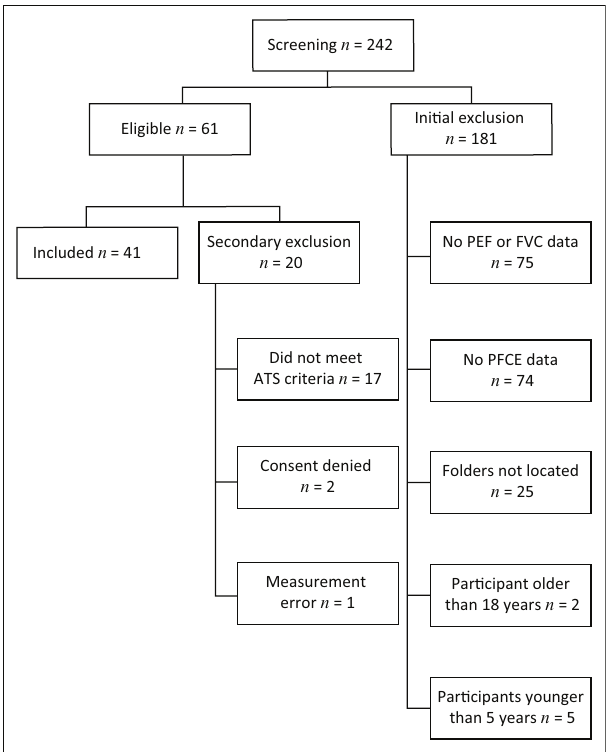
FIG URE 1: Flowchart of participants through the